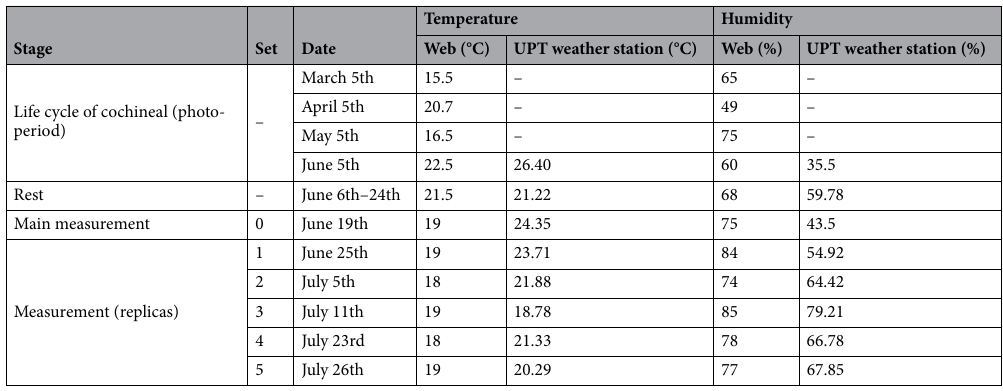
Table 3. Temperature and humidity registered on online and the UPT weather station from cochineal life cycle (photoperiod) stages until the experimental fluorescence measurements.